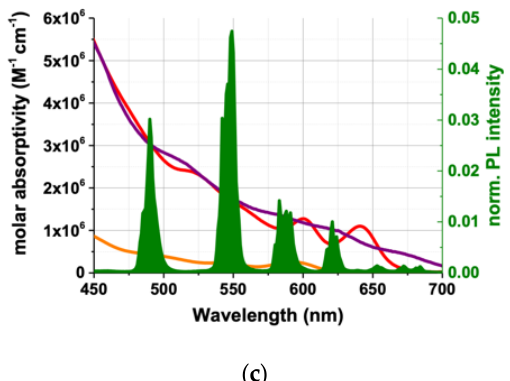
Figure 2. ( a ) Absorption (dash dotted lines) and PL (solid lines) of eQD605 (orange), eQD650 (red), and iQD705 (purple). ( b ) Pulsed (405 nm diode laser at 1 MHz for eQD605/650 and 0.5 MHz for iQD705) excitation was used to measure the PL decay curves at the respective PL peaks of the quantum dots (QDs). The multi ‐ exponential decay curves resulted in amplitude ‐ averaged decay times of τ (eQD605, orange) = 7.4 ± 0.9 ns, τ (eQD650, red) = 17.4 ± 2.5 ns, and τ (iQD705, purple) = 63.5 ± 10.8 ns. ( c ) Overlap between QDs absorption spectra (eQD605: orange; eQD650: red; iQD705: purple)